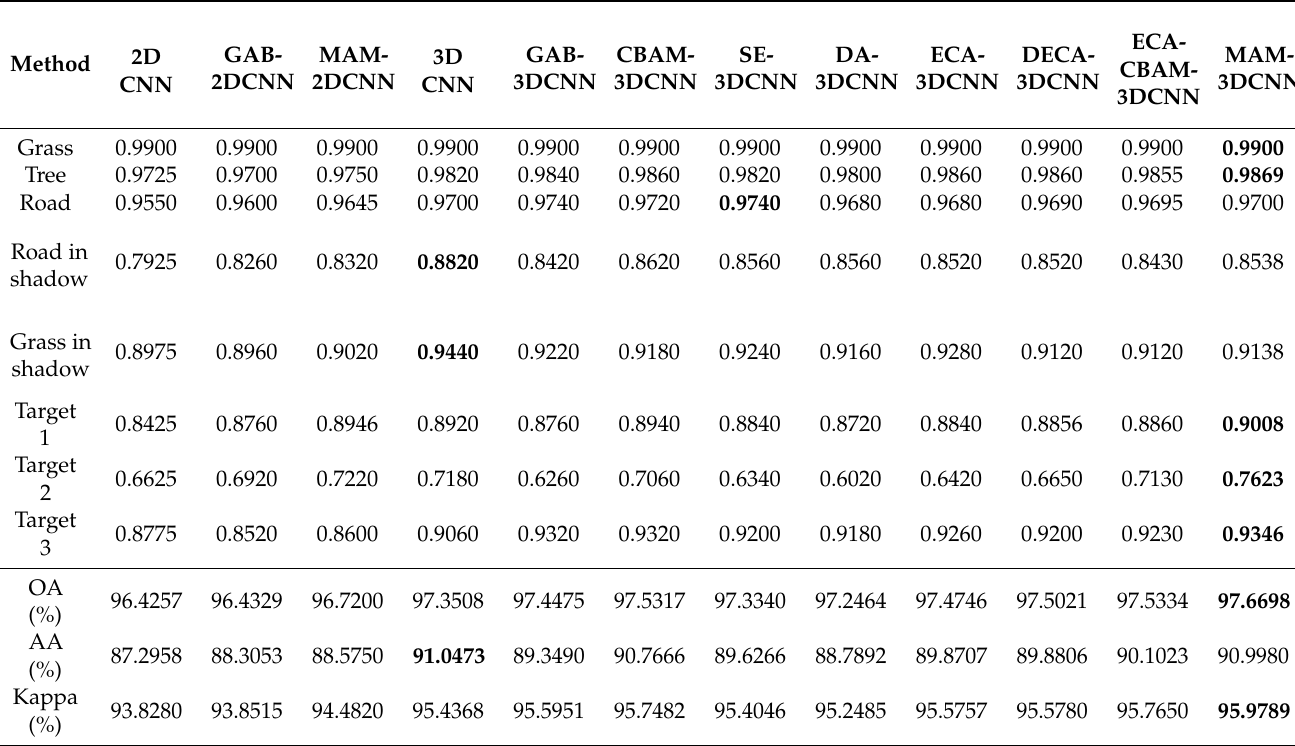
Table 5. Classification accuracy of the considered methods. The 2DCNN and 3DCNN with different attention modules are